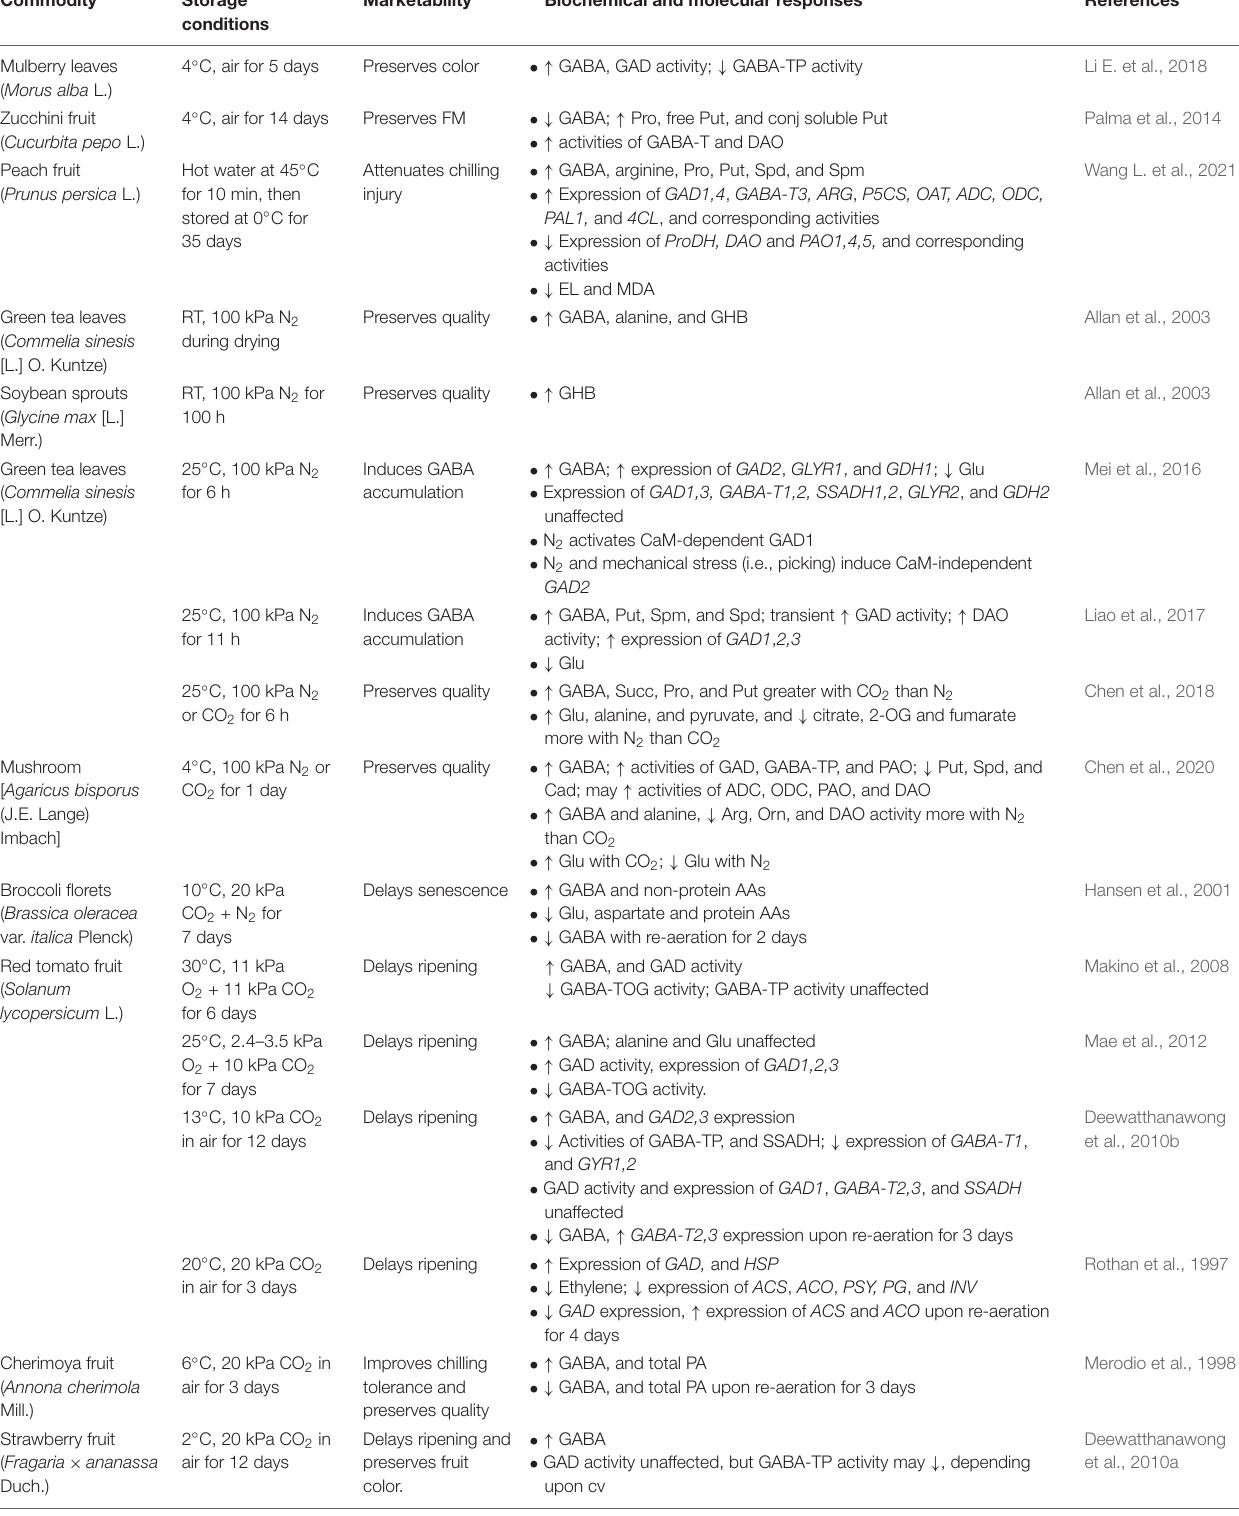
TABLE 1 | Postharvest storage conditions improve the marketability of horticultural commodities and promote GABA